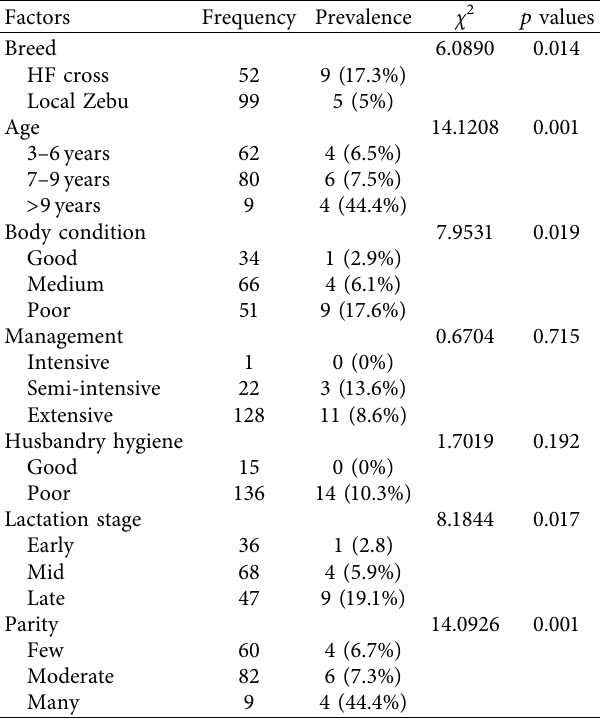
Figure 2: Te overall prevalence of Salmonella in the study area. Table 1: Risk factors associated with the prevalence of Salmonella identifed from milk samples in the study